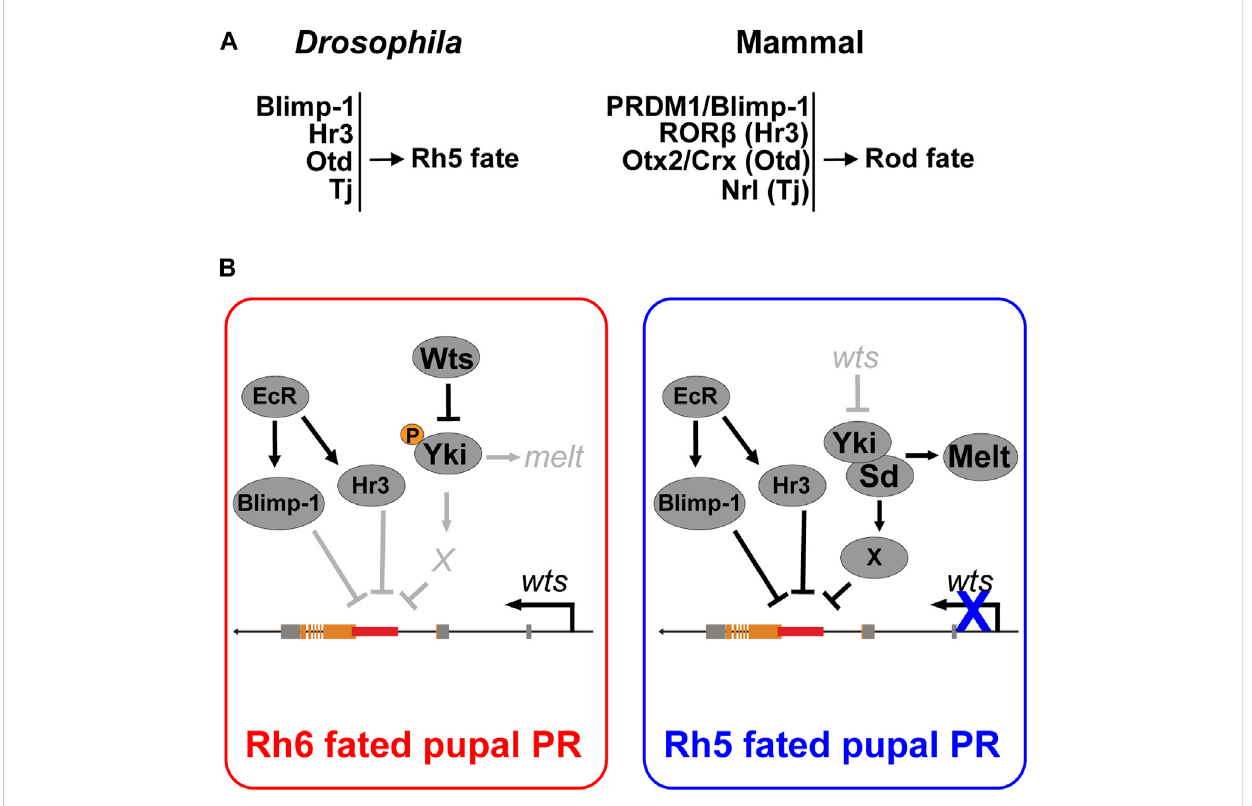
FIGURE 7 Cell fate decisions in the Drosophila and mammalian retina. (A) Summary of conserved transcription factors that are necessary to specify Rh5 photoreceptor fate in Drosophila and rod photoreceptor fate in mammals. (B) Model for Blimp-1 ’ s function as a permissive factor that represses wts at the transcriptional level in parallel with the ecdysone-responsive Hr3. Blimp-1 is expressed in pupal PRs in an EcR-dependent manner, but when Yki is not activated, Blimp-1 is not suf fi cient to repress wts and thereby gives rise to Rh6 fate. However, when Yki is transiently activated, possibly in response to the TGF β signal from the distal R7 photoreceptor, Yki/Sd activate an unknown Rh5 subtype-speci fi c transcription factor “ X ” that acts in combination with Blimp-1 and Hr3 to repress the wts enhancer, thereby silencing wts transcription and giving rise to robust Yki activation as well as Rh5